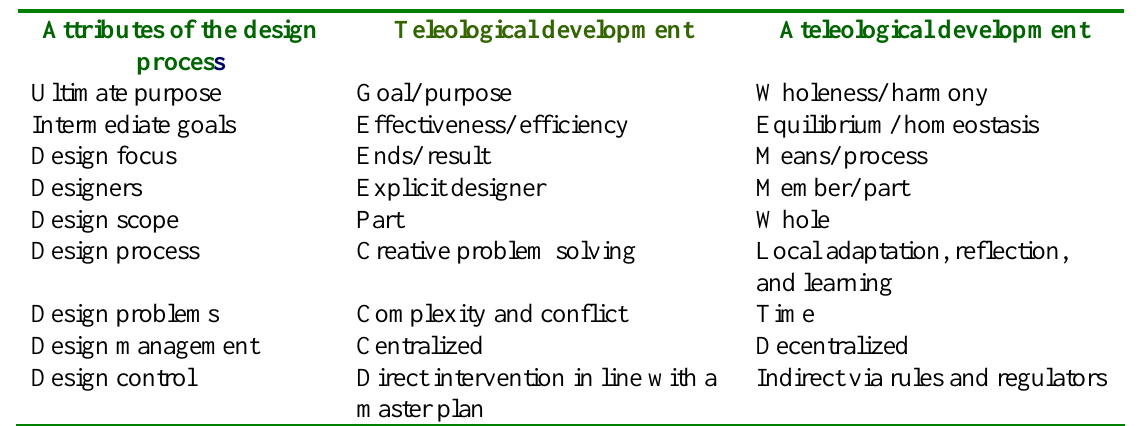
Table 1. Teleological and Ateleological Development Systems (adapted from Introna, 1996, p.